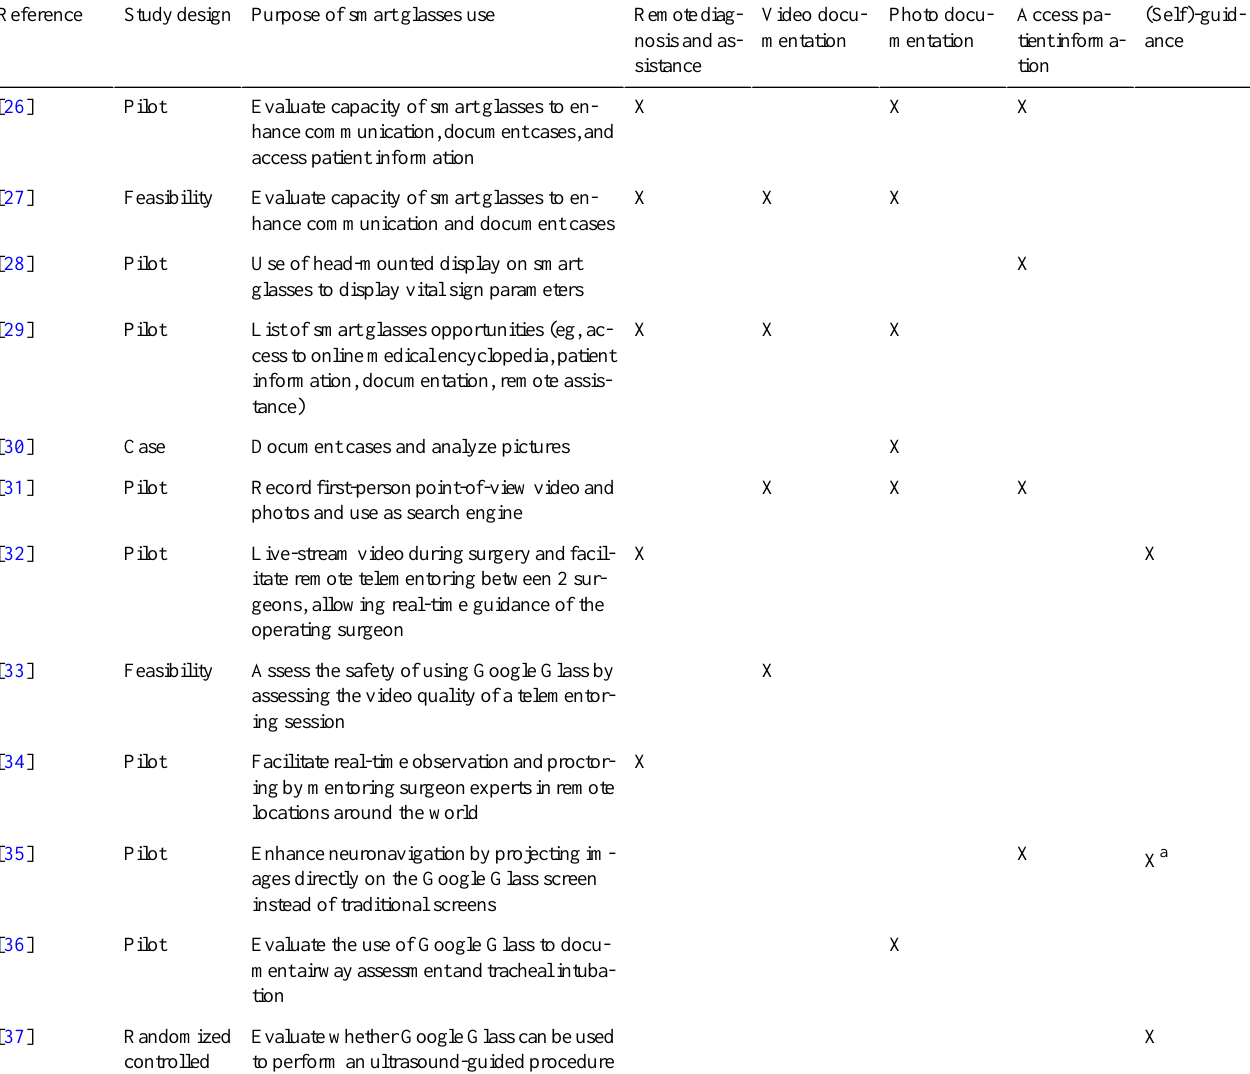
Table 1. Existing research on the uses of smart glasses in health